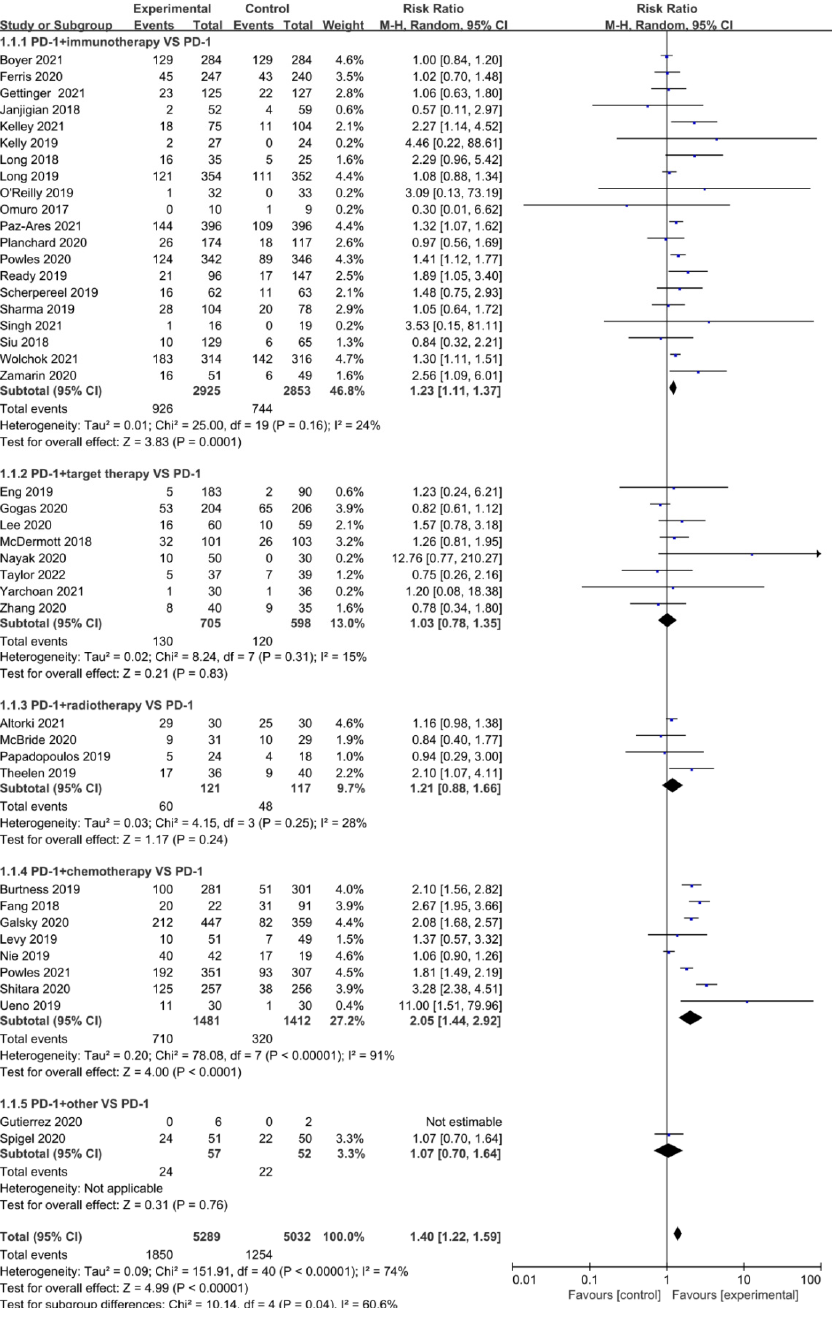
Figure 2. Forest Plot of the Risk ratio of ORR based on therapeutic schedules: anti-PD-1/PD-L1 versus combination therapy (immunotherapy, targeted therapy, radiotherapy, chemotherapy, and other drugs). Boyer 2021 [12] , Ferris